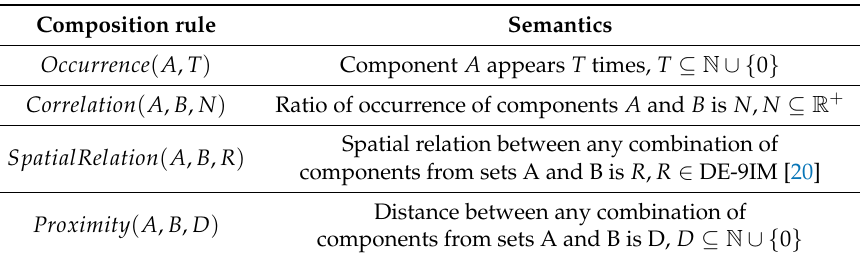
Table 2. Composition rules